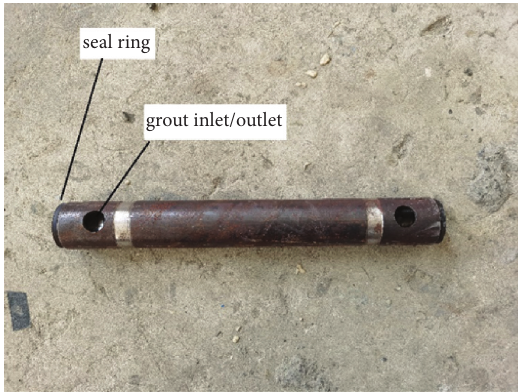
Figure 1: Full-grouted sleeve. Table 1: Reinforcement